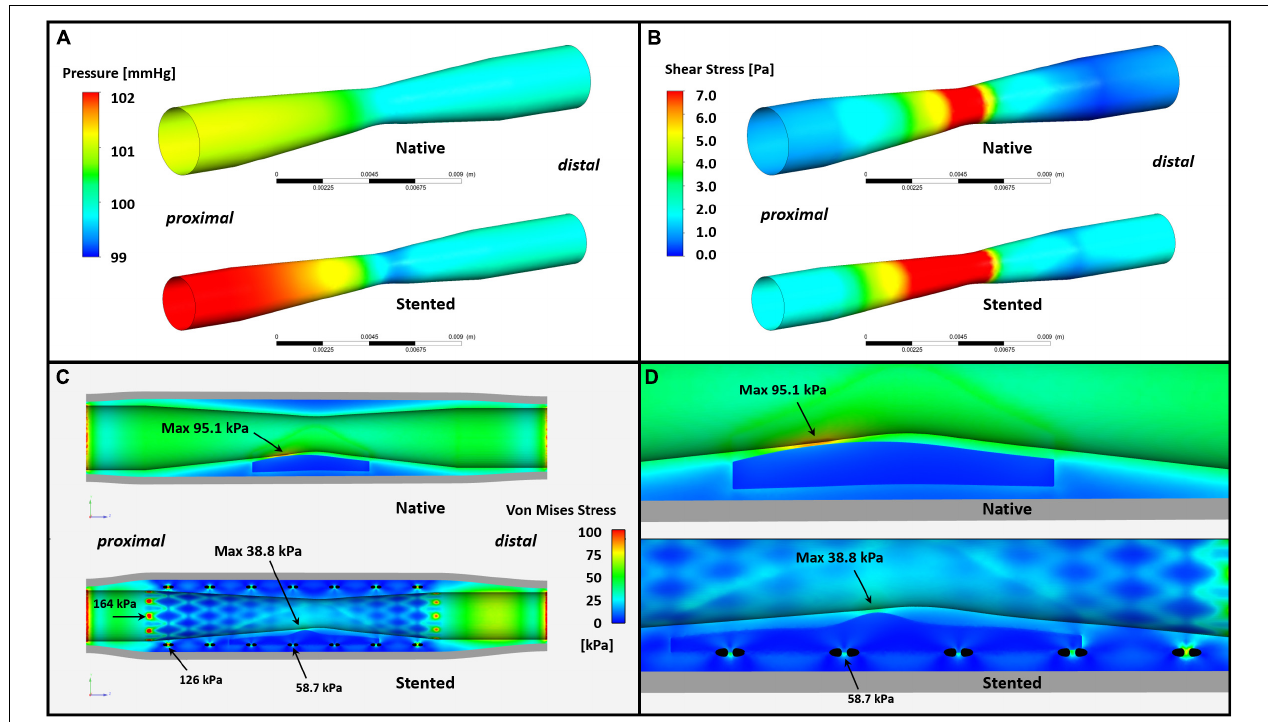
FIGURE 5 | Computational physiological analysis results. (A) The pressure drop across the model is 0.95 and 2.03 mmHg for native and stented vessel, respectively. (B) ESS distribution of the vessel. The stented model reveals higher maximum and minimum ESS value (19.1 vs. 11.0 Pa and 0.32 vs. 0.04 Pa, respectively). The maximum ESS value was located main at the MLA in both two models and 28.5% of the culprit lesion model in the stented segment and 9.0% of the culprit lesion model in NV was exposed to high ESS ( > 7 Pa). (C,D) PSS analysis results. The maximum superficial PSS in both models were over the thinner segment of the fibrous cap proximally to the MLA and was 95.1 kPa in the native and 38.8 kPa in the stented segment. A total of 95.1 kPa was also the maximum PSS value of the native model while in the stented model the highest PSS was 58.7 kPa in the vicinity of stent